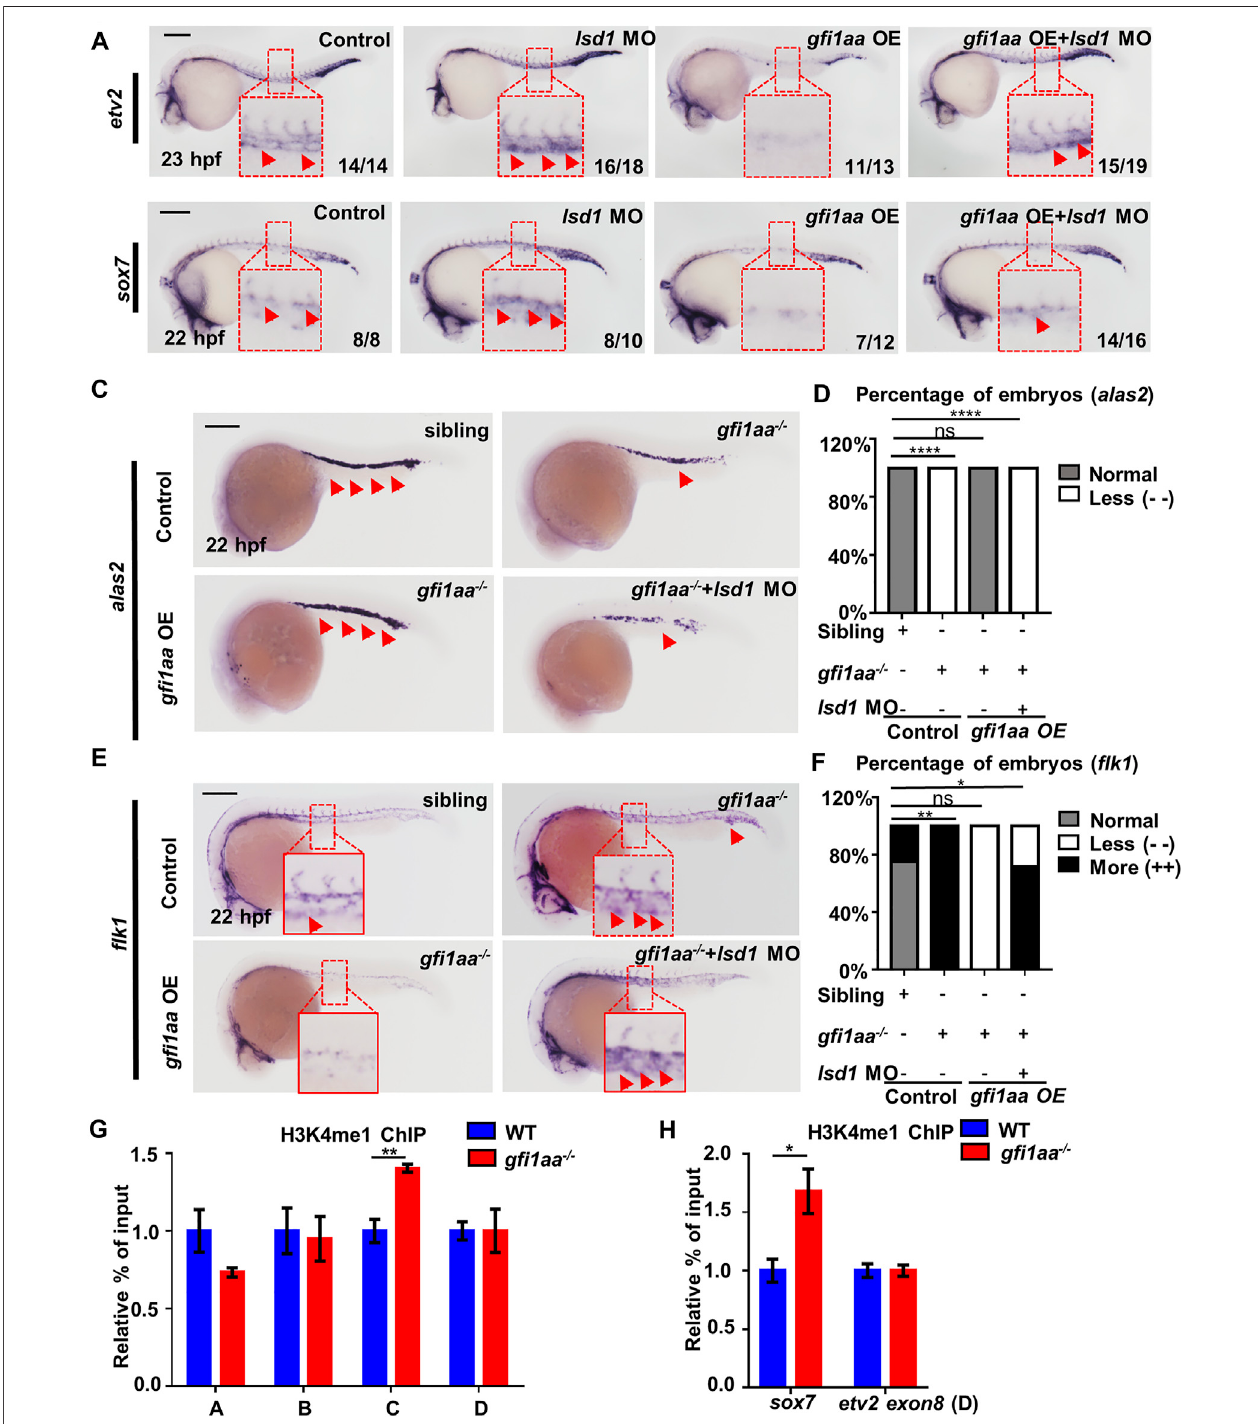
FIGURE5| G fi 1aatargets etv2andsox7 inanLsd1-dependentmanner (A,B) G fi 1repressionactivityon etv2 and sox7 transcriptiondependsonLsd1.Expression of etv2 (A) and sox7 (B) inWT, lsd1 MO, g fi 1aa overexpression( g fi 1aa -OE)embryos,and g fi 1aa -OEembryosco-injectedwith1 pmol lsd1 MO. g fi 1aa -OEembryoswere theprogeniesof hsp-g fi 1aa-eGFP transgenic fi sh.Theredboxesindicate themagni fi cationof etv2 signals (A) and sox7 signals (B) intheICMregion.n ≥ 10embryosfor each group. The numbers in the bottom right corner indicate the percentage of embryos exhibiting the representative expression of indicated genes. Scale bar: 200 μ m (C,D) Expression (C) and analysis (D) of erythroid marker alas2 in sibling, g fi 1aa − / − mutant, g fi 1aa- OE rescued g fi 1aa − / − mutant and g fi 1aa − / − mutant with g fi 1aa- OE and lsd1 -MO at 22 hpf (E,F) Expression (E) and analysis (F) of endothelial marker fl k1 in sibling, g fi 1aa − / − mutant, g fi 1aa- OE rescued g fi 1aa − / − mutant